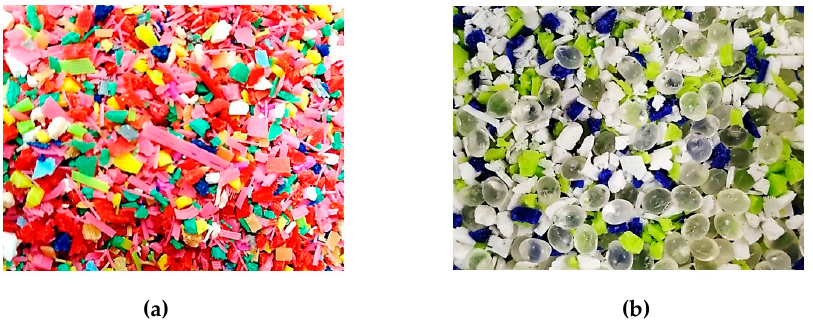
Figure 5. Recycled PLA waste. ( a ) 100% shredded PLA, ( b ) combination of recycled (70%) and virgin PLA pellets (30%).